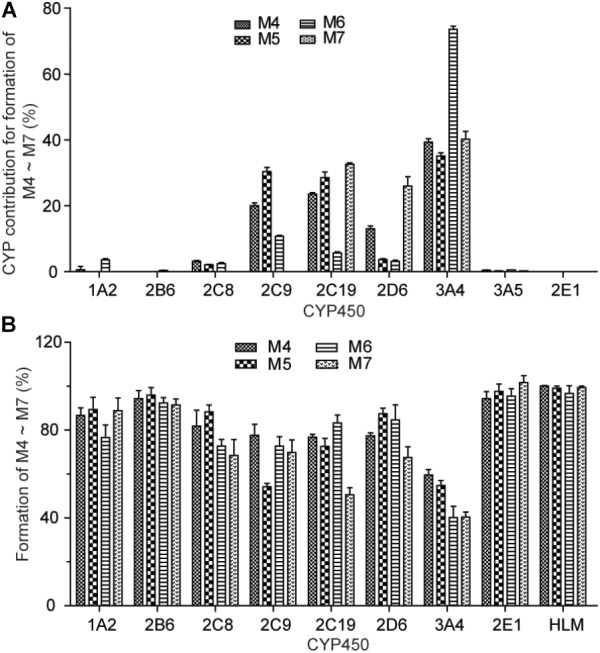
Formation of M4∼M7 with recombinant human CYP450 enzymes (A). Effect of selective CYP450 inhibitors on the formation of GSH conjunction M4–M7 in incubations of corynoline with human liver mirosome (B).